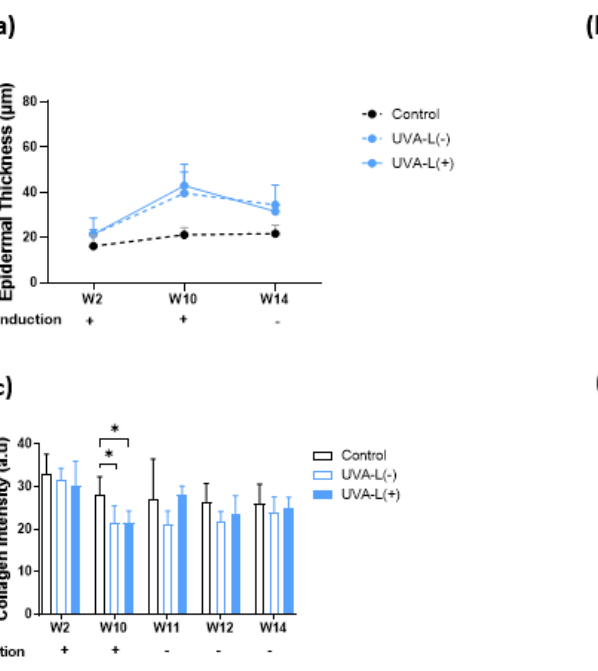
Figure 4. Effect of 755 nm picosecond laser on OCT epidermal thickness and collagen intensity in ( a,c ) UVA-irradiated and ( b,d ) UVB-irradiated nude mice. W2, UVA baseline; W10, complete induc-